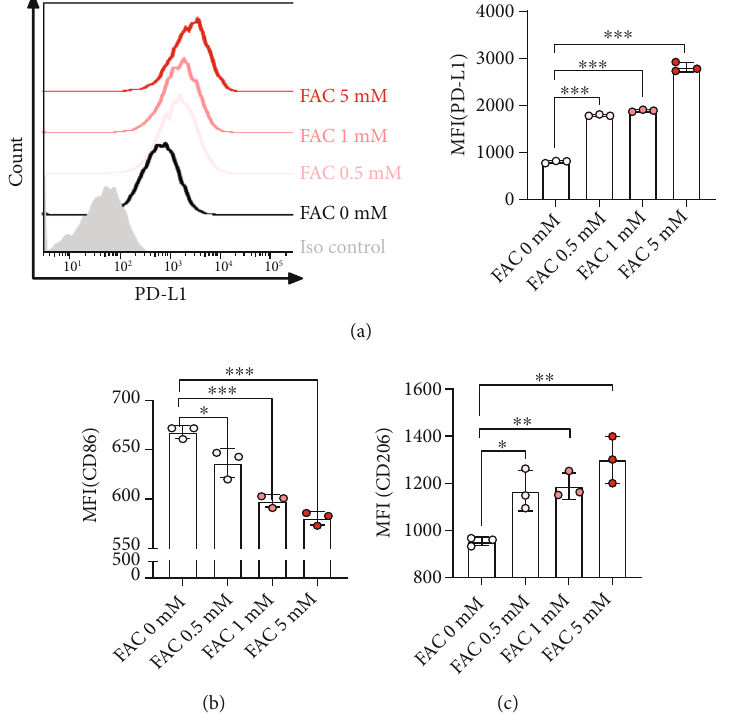
Figure 1: E ff ects of FAC on macrophage PD-L1 expression. BMDMs were incubated with FAC at concentrations of 0.5, 1, and 5mM for 16h. PD-L1 (a), CD86 (b), and CD206 (c) in F4/80 + macrophages were measured by fl ow cytometry. The scatterplot with the bar graph illustrates the mean fl uorescence intensity (MFI) of each surface marker. ∗ indicates signi fi cant di ff erences ( ∗ P < 0 : 05 , ∗∗ P < 0 : 01 , and ∗∗∗ P < 0 : 001 ) from the control